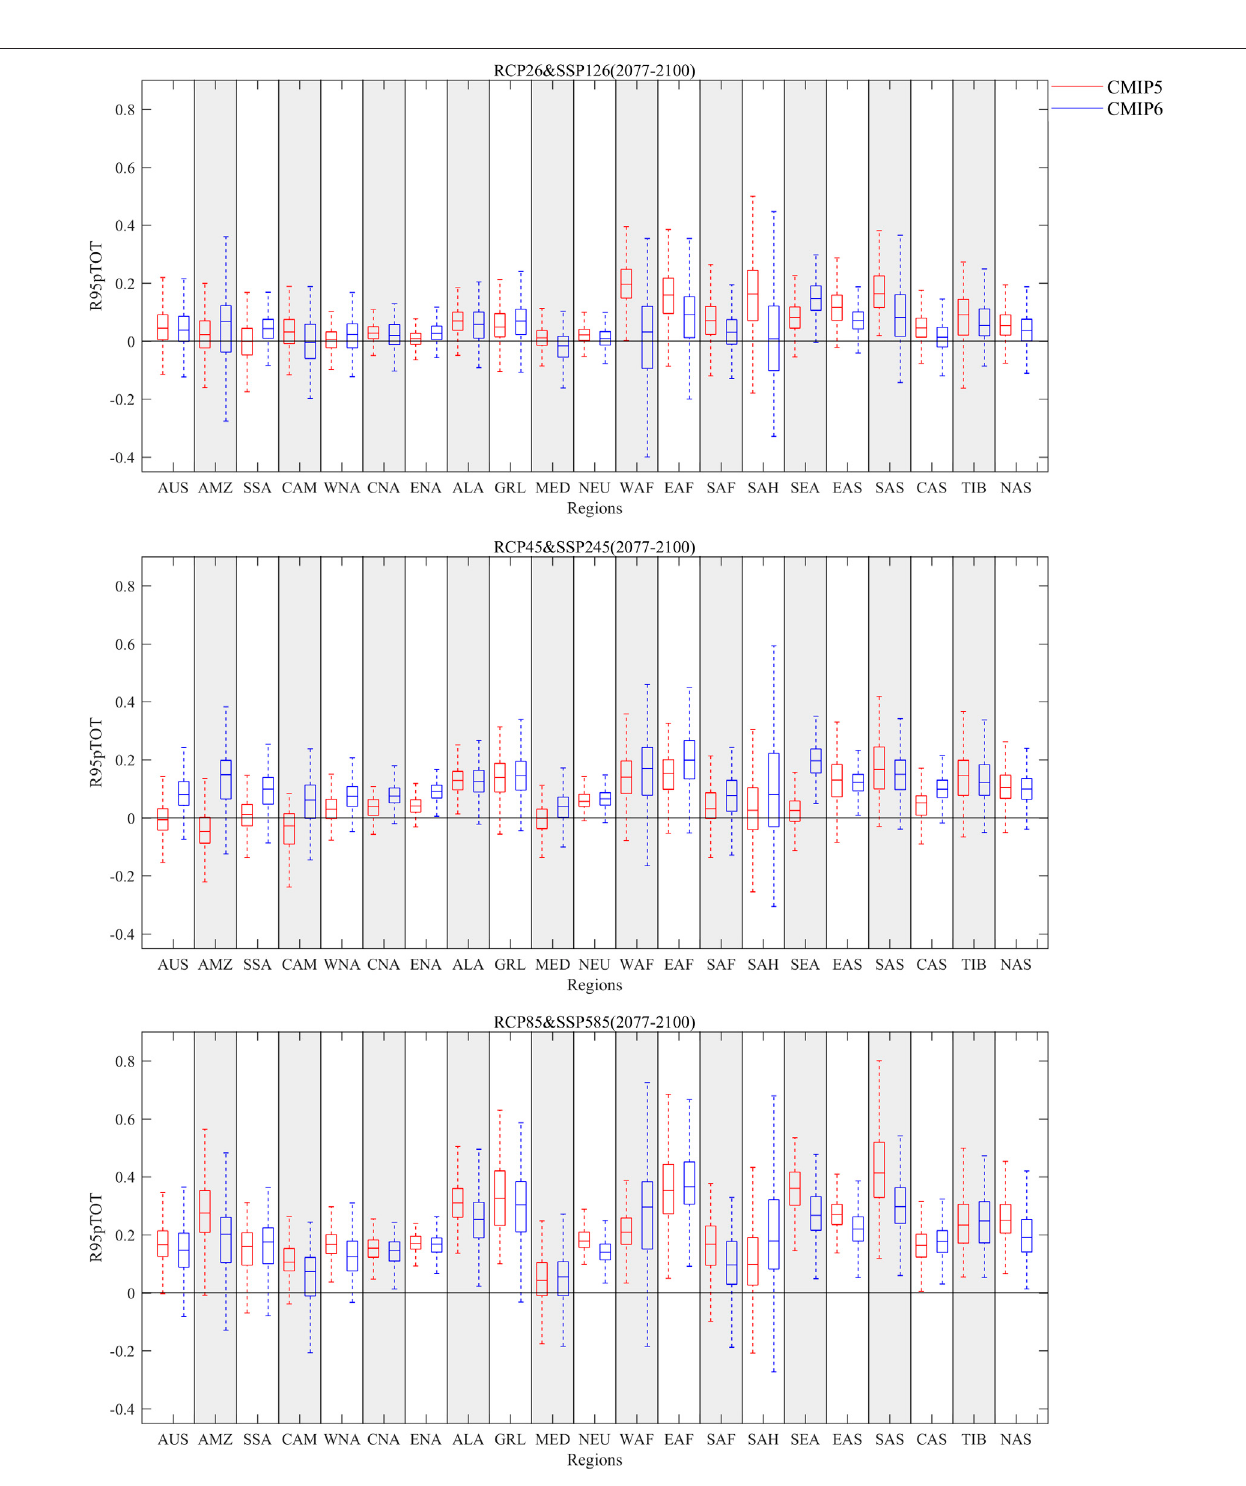
FIGURE 10 | Box plots for R95pTOT multi-model mean changing rates in 21 regions in far-future period (2068 – 2100) over the historical period (1982 – 2005) in CMIP5 and CMIP6. CMIP5 is presented in red and CMIP6 is presented in blue.